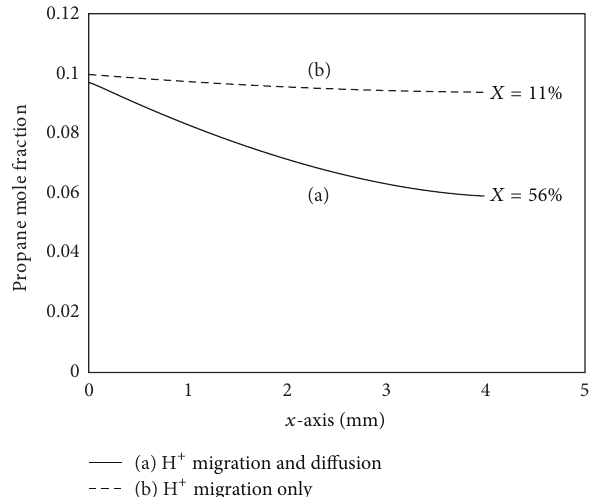
Figure 9: Propane mole fraction in the gas phase of the anode catalyst layer along the 𝑥 -direction at the middle of the anode cata- lyst layer. (a) Proton migration plus diffusion within the electrolyte phase (the present model). (b) Proton migration only within the electrolyte phase [5].